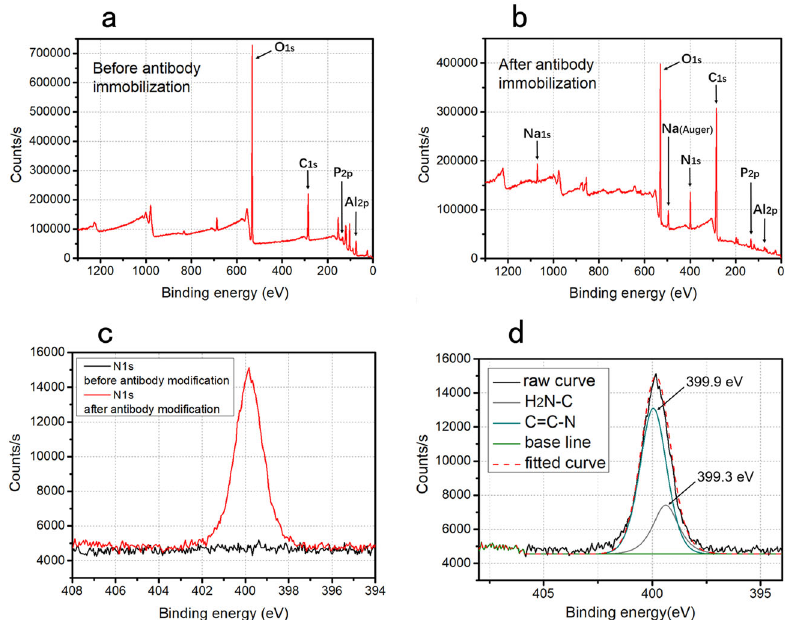
Fig. 1 Characterization for sensor ’ s functionalization by XPS spectrums. Full spectrum on a thoroughly cleaned IDME surface before antibody modi fi cation and b functionalized IDME surface after antibody modi fi cation. c High-resolution spectrums of nitrogen (N1s) before and after IDME modi fi cation. d The peak differentiating and imitating of N1s.